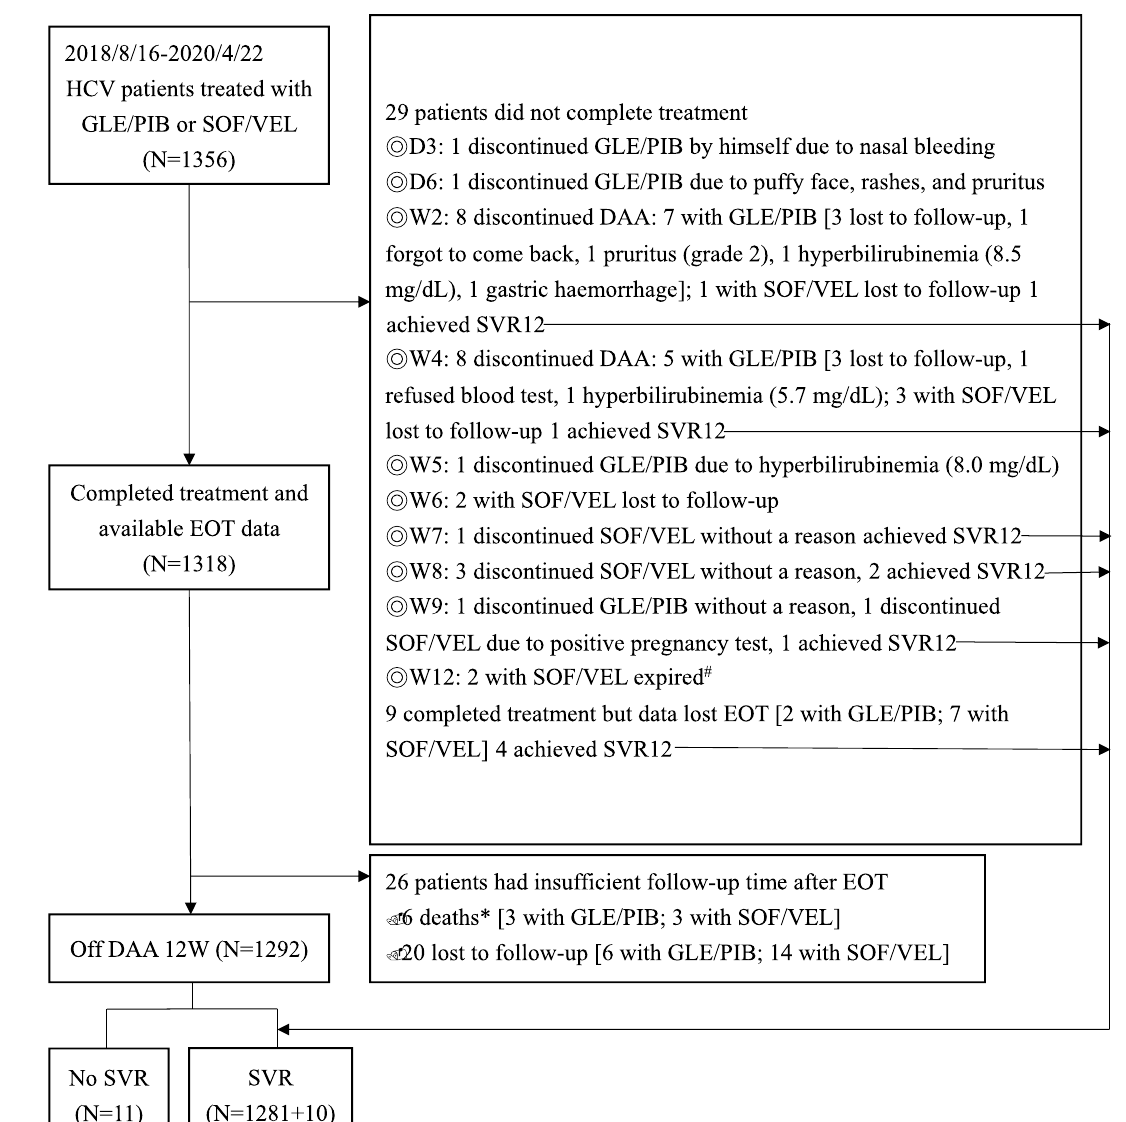
DAA, Two due to sepsis 1 week and 5 weeks, respectively, off DAA, one due to biliary tract infection with septic shock 10 weeks off DAA, one due to lung cancer or pneumonia 9 weeks off DAA, and one due to out-of-hospital cardiac arrest of unknown cause 6 weeks off DAA. DAA direct-acting antiviral; SVR12 sustained virological response 12 weeks after treatment cessation; GLE/PIB glecaprevir/pibrentasvir; SOF/VEL sofosbuvir/velpatasvir; HCV hepatitis C virus; EOT end of